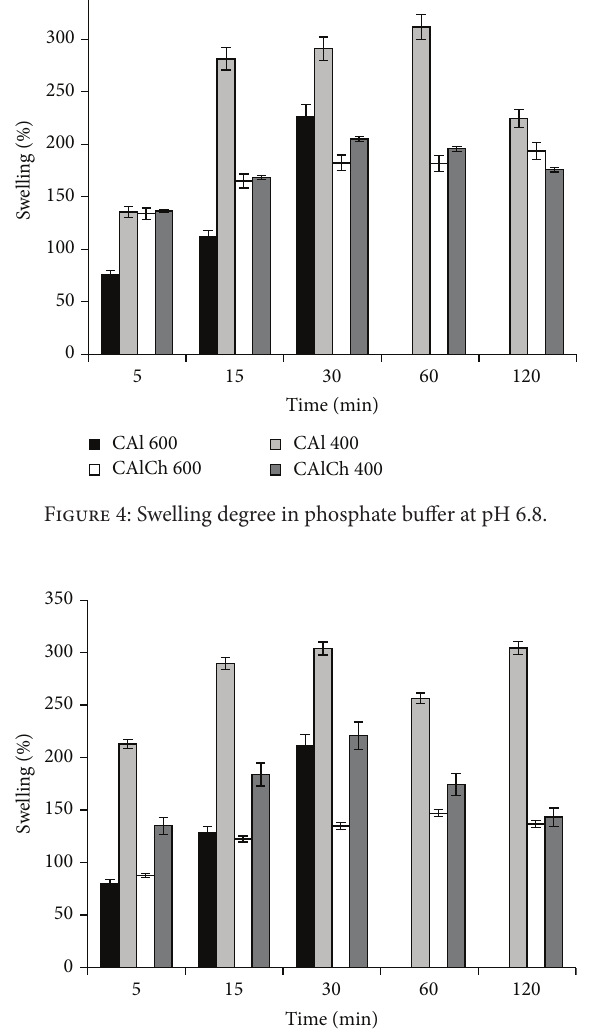
Table 2: Average diameter and celecoxib content of the dry beads.